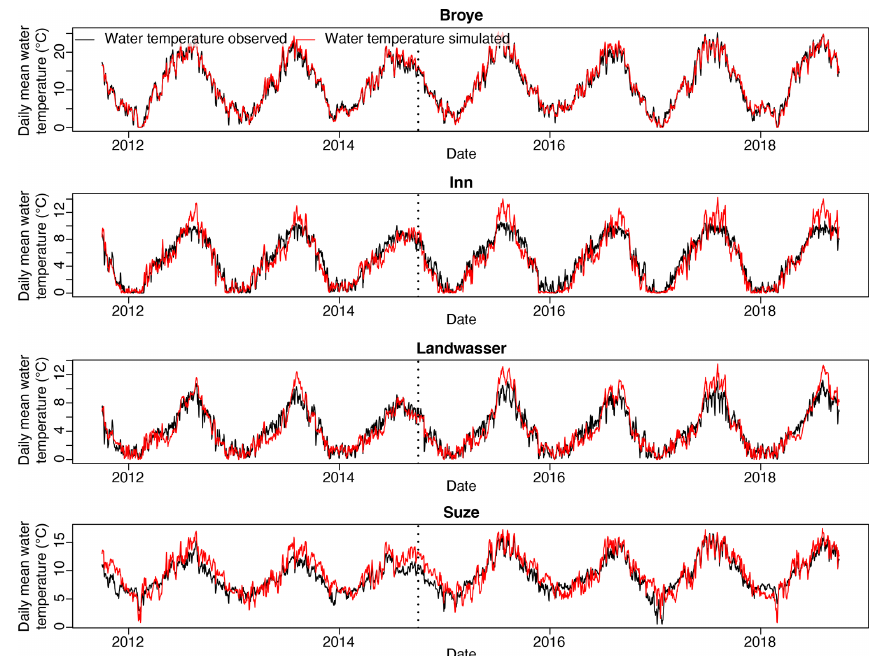
Figure 3. Daily mean water temperature observed (black) and simulated (red) over the calibration periods (left of dotted line) and over the validation period (right of dotted line) for four catchments: the Broye (Swiss Plateau), the Inn (Alpine), the Landwasser (Alpine), and the Suze (Swiss Plateau). These four catchments were chosen to represent the variation in the catchment type. Note that the extent of the y axes (daily mean water temperature range) is different for every panel. Other catchments are shown in Sect. S6.